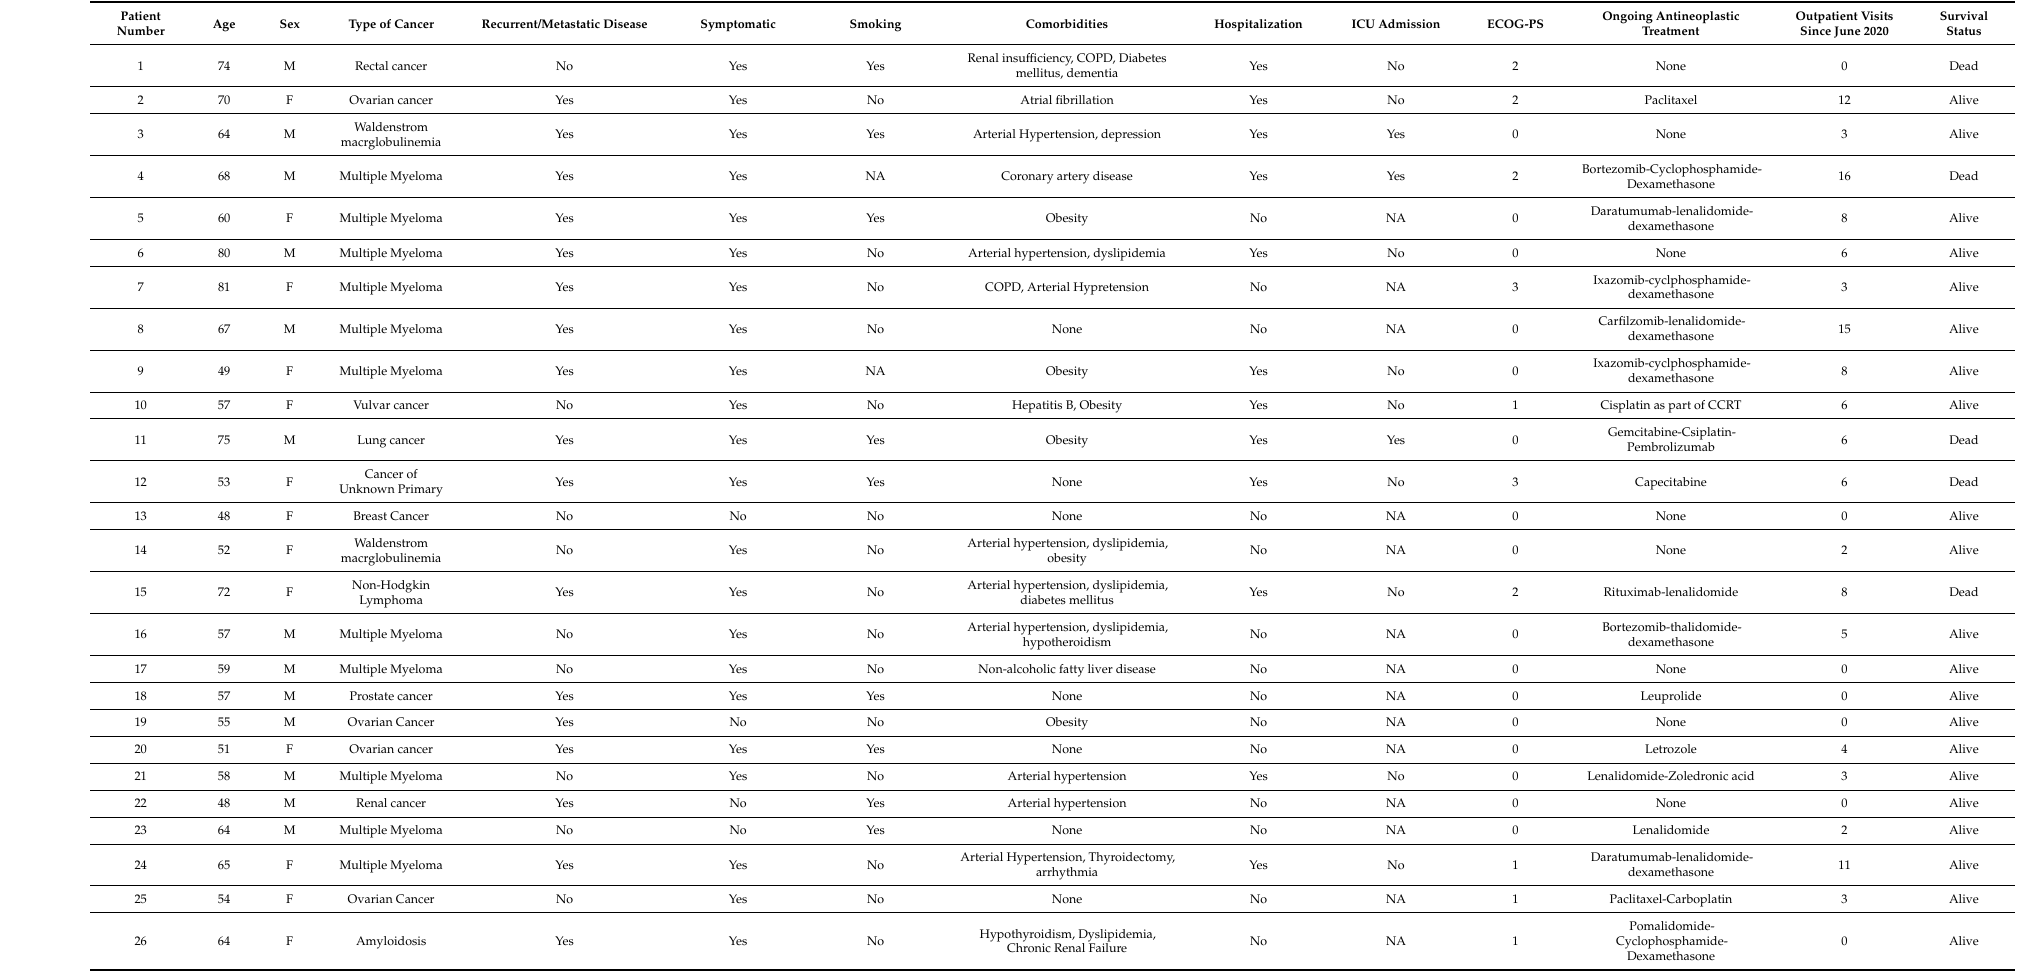
Table 1. Clinical characteristics of the